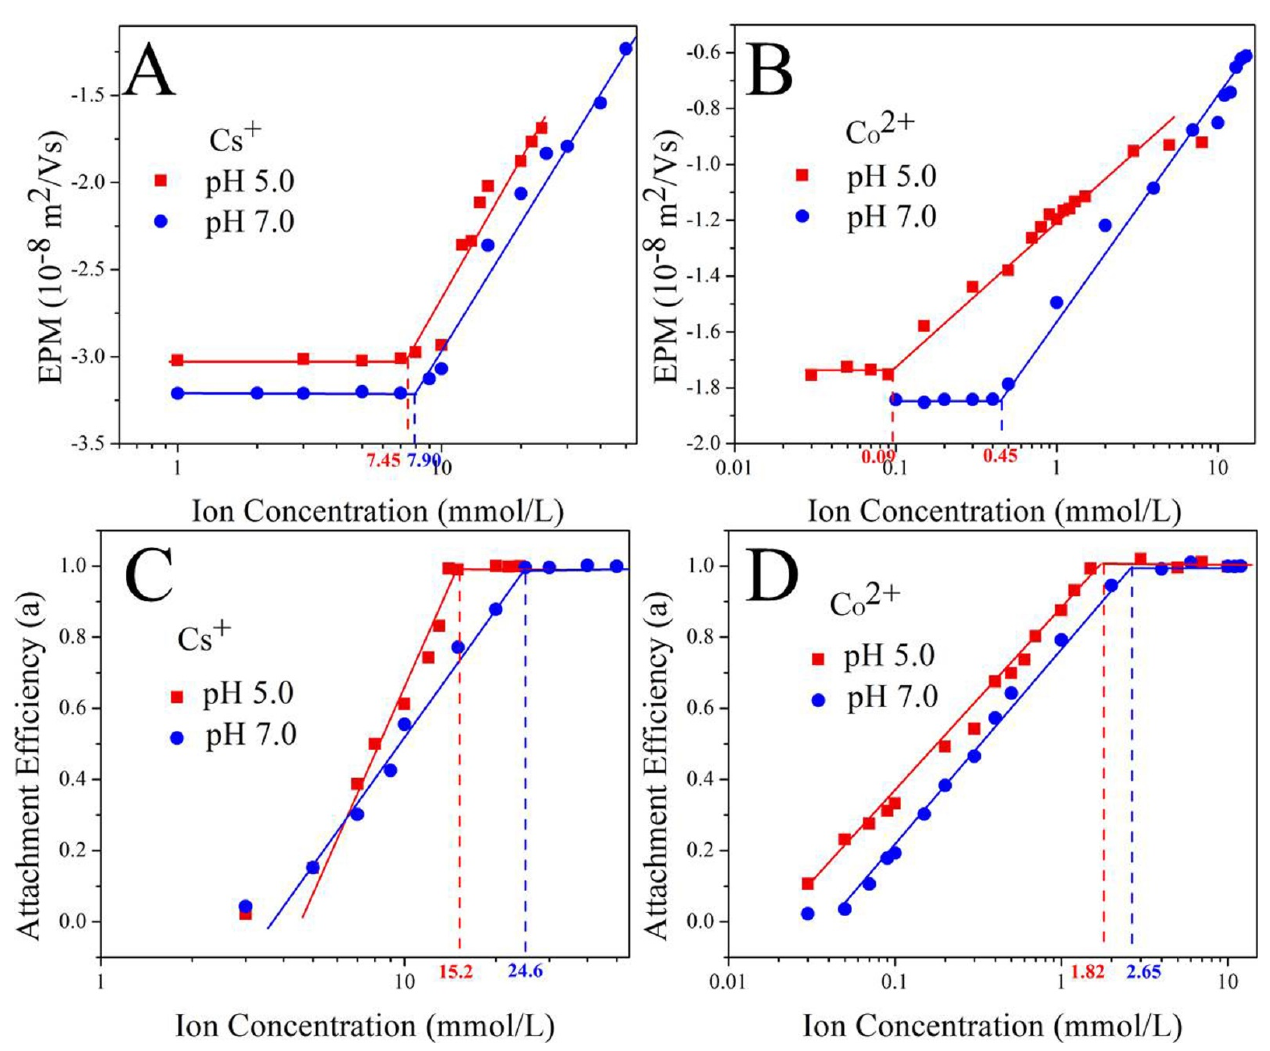
Figure 2. EPM and α of HA (50 mg/L) aggregates as a function of Cs + or Co 2+ concentration at pH 5.0 and 7.0 (measurements were taken at 25 °C). (( A ): EPM changes of HA in the presence of Cs + ; ( B ): EPM changes of HA in the presence of Co 2+ ; ( C ): α changes of HA in the presence of Cs + ; ( D ): α changes of HA in the presence of Co 2+ ).